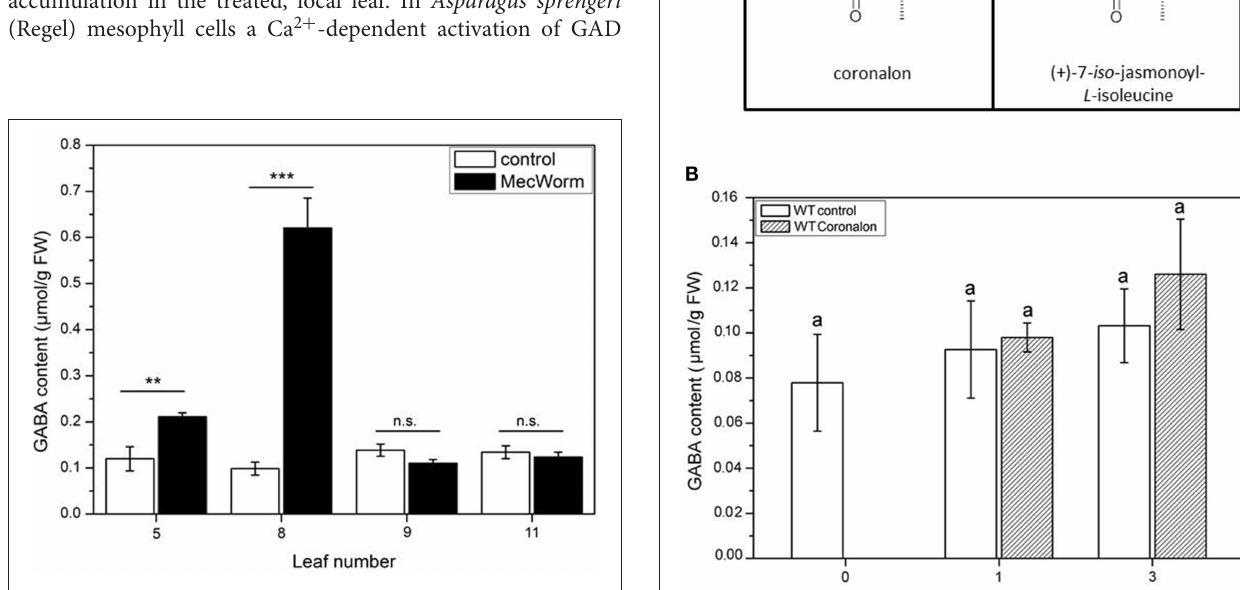
FIGURE 7 | Accumulation of GABA in individual Arabidopsis leaves after MecWorm treatment. Mean ( ± SE, n = 5 ) levels of GABA were determined in individual leaves of untreated control plants and plants after treatment for 1h with MecWorm. In treated plants, leaf 8 was subjected to mechanical damage and systemic leaves 5, 9, and 11, and treated leaf 8 were analyzed for GABA level. Statistically significant differences between the GABA level in the same leaf of the control and treated plant were analyzed by t -test (for each leaf separately, p < 0.05 , Mann-Whitney-U test), ** P ≤ 0.01 ; *** P ≤ 0.001.